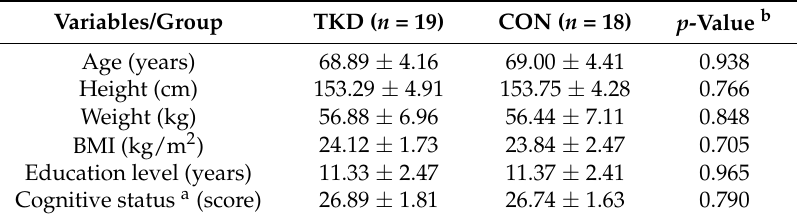
Table 1. Participant